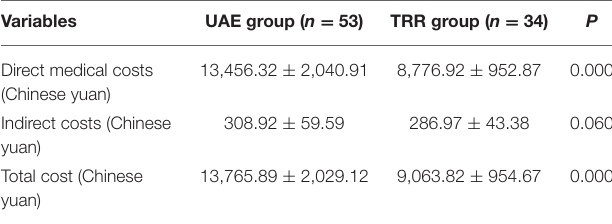
TABLE 3 | Cost analysis of patients with CSP treated with UAE before curettage or